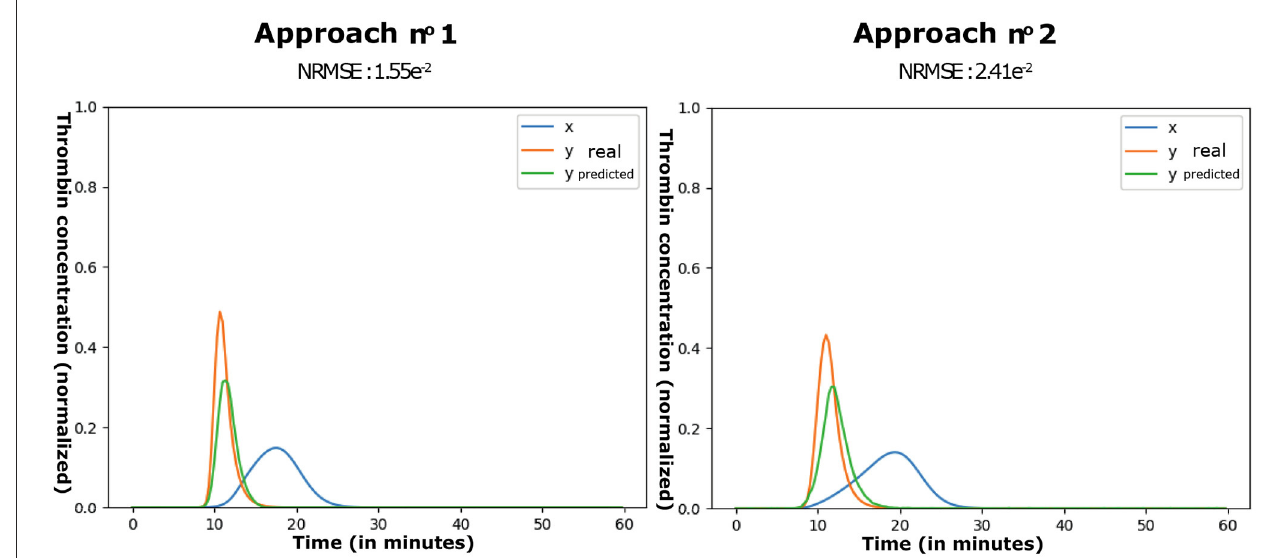
FIGURE6 Examples of predictions by approaches n. o 1 and 2.